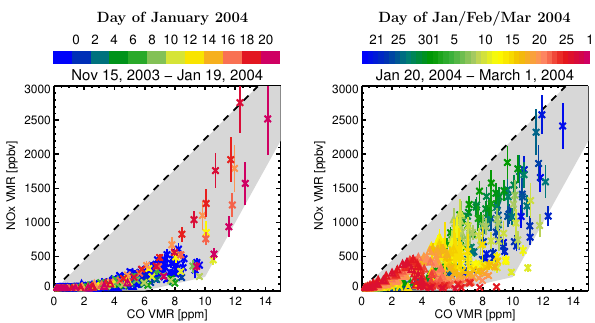
Figure 6. Scatterplot of NO x and CO as observed by MIPAS within the polar vortex throughout NH winter 2003–2004. Left: from 15 November 2003 to 19 January 2004, considering observations in the altitude range 40–70km. The symbols are color-coded by time, with blue denoting days in 2003, and the days in January 2004 run- ning from green–yellow–orange–red. Dark red is 19 January. The dashed line marks the secant to this distribution; light grey marks the region incorporated by the observed distribution and its secant. Right: from 20 January to 1 March 2004. Grey area and dashed line as in left panel. Colors mark the day, running from dark blue– green–yellow–orange–red. Error bars show the error of the mean of the daily averages of NO x